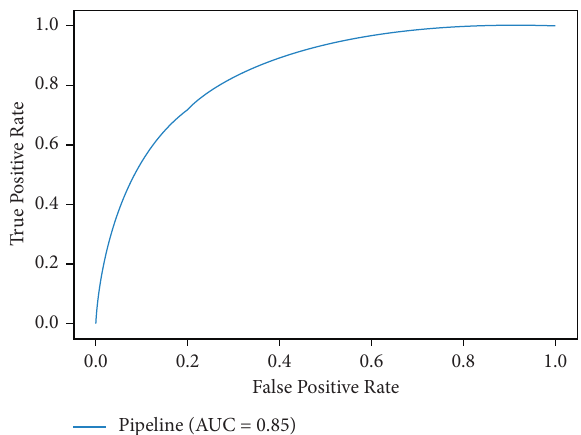
Figure 2: Final AUC for the test set of the hyperparameter op- timized model. Pipeline: Iterative Imputer, Label Encoding, Target Encoding, Standard Scaler, and XGBoost